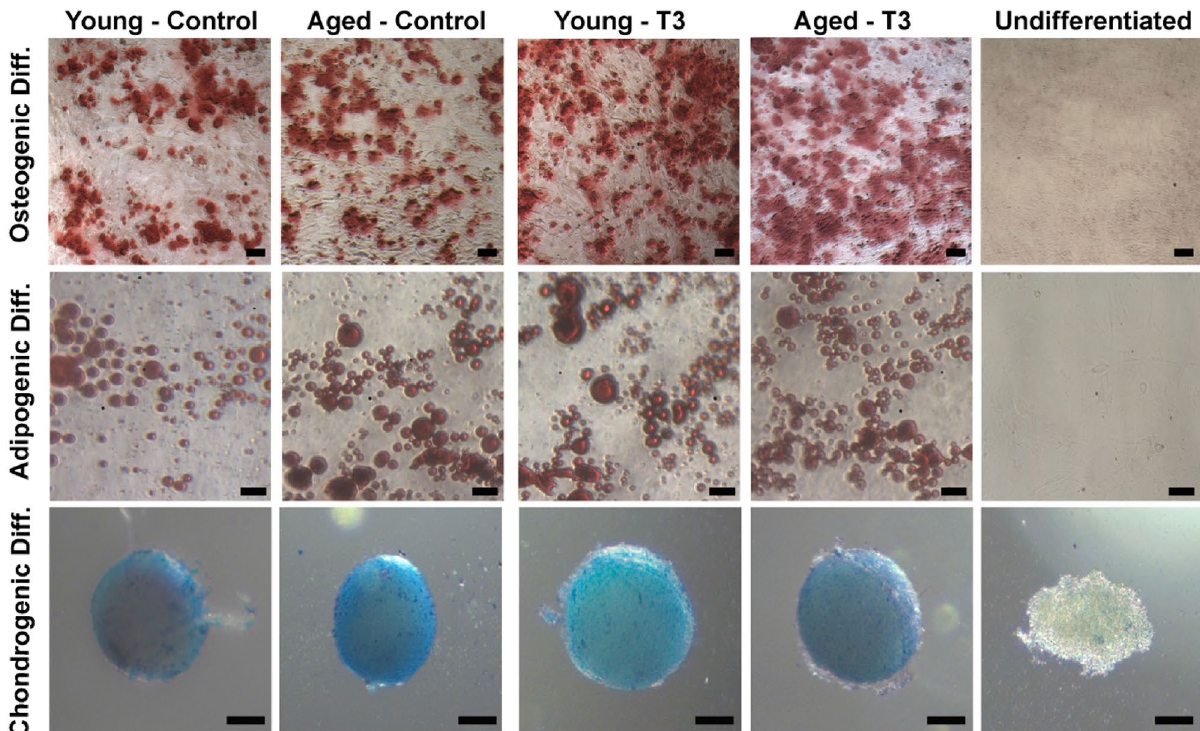
Figure 10. Effects of multiple doses of PBM on multi-lineage differentiation potential of young and aged MSCs: Young and aged MSCs underwent a PBM treatment at 3 J/cm 2 for 3 (T3) days in a row while untreated MSCs served as controls. On day 7, the cells from both the control and experimental groups were harvested and subjected to differentiation experiments. Undifferentiated cells were cultured in a DMEM/F-12-based culture medium. Shown are representative images of osteogenic, adipogenic, and chondrogenic differentiation with Alizarin Red, Oil Red-O, and Alcian blue staining, respectively. In addition, representative images of undifferentiated cells stained with the same dyes are also shown. Scale bars: 50